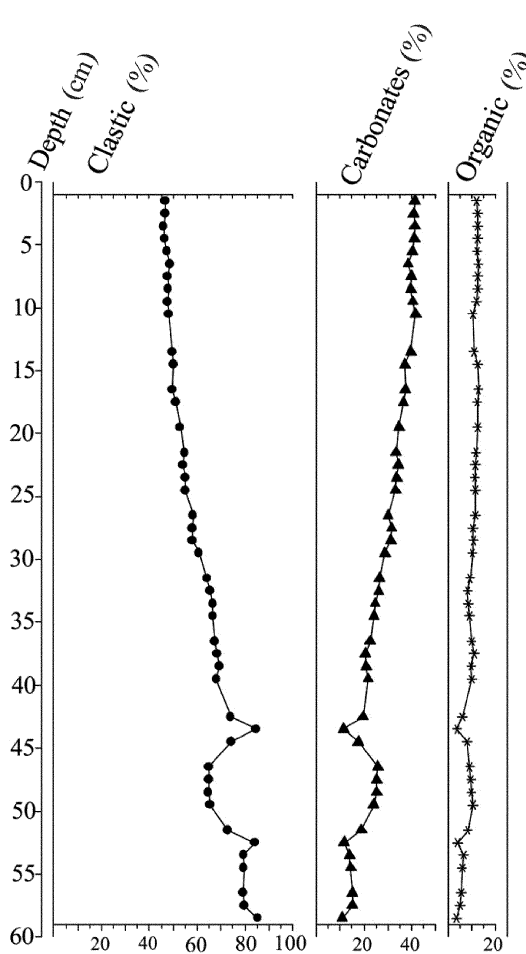
Fig. 2. The percentages of clastic, carbonate and organic matter according to LOI results in the sediment